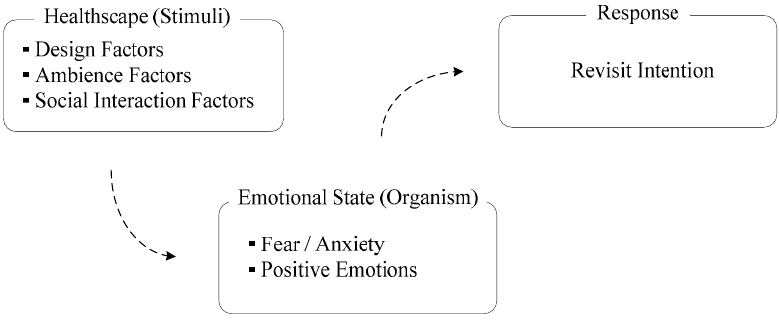
Figure 2. Modified stimulus-organism-response (SOR) model.